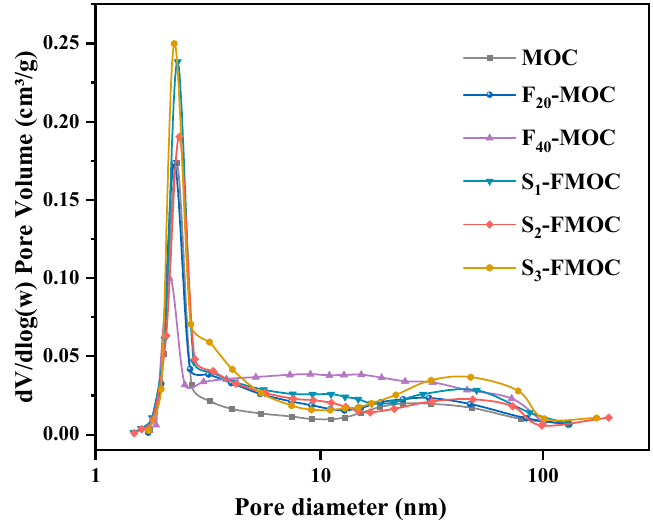
Figure 17. Log differential intrusion curves of hardened multi-doped MOC.